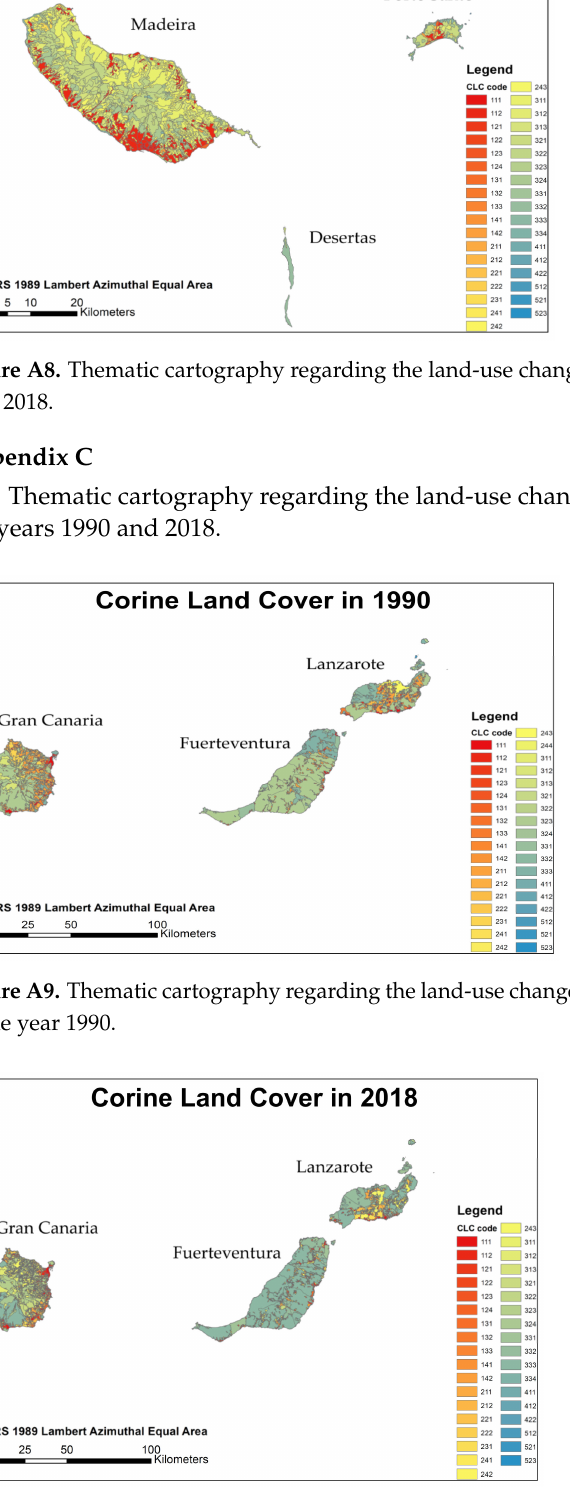
Figure A10. Thematic cartography regarding the land-use changes in the North of Canary Archipelago in the year